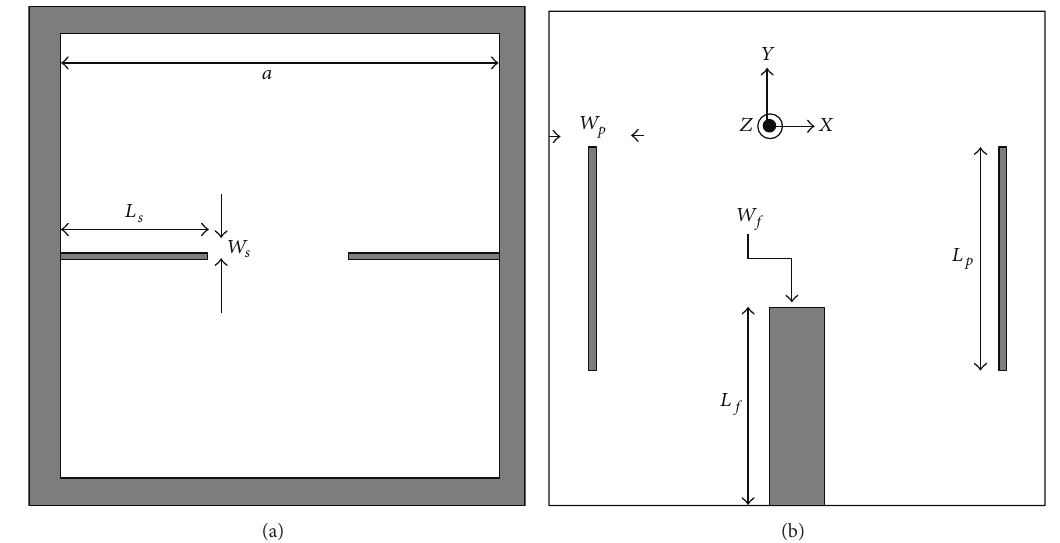
Figure 1: Configuration of an antenna element, (a) front view and (b) back